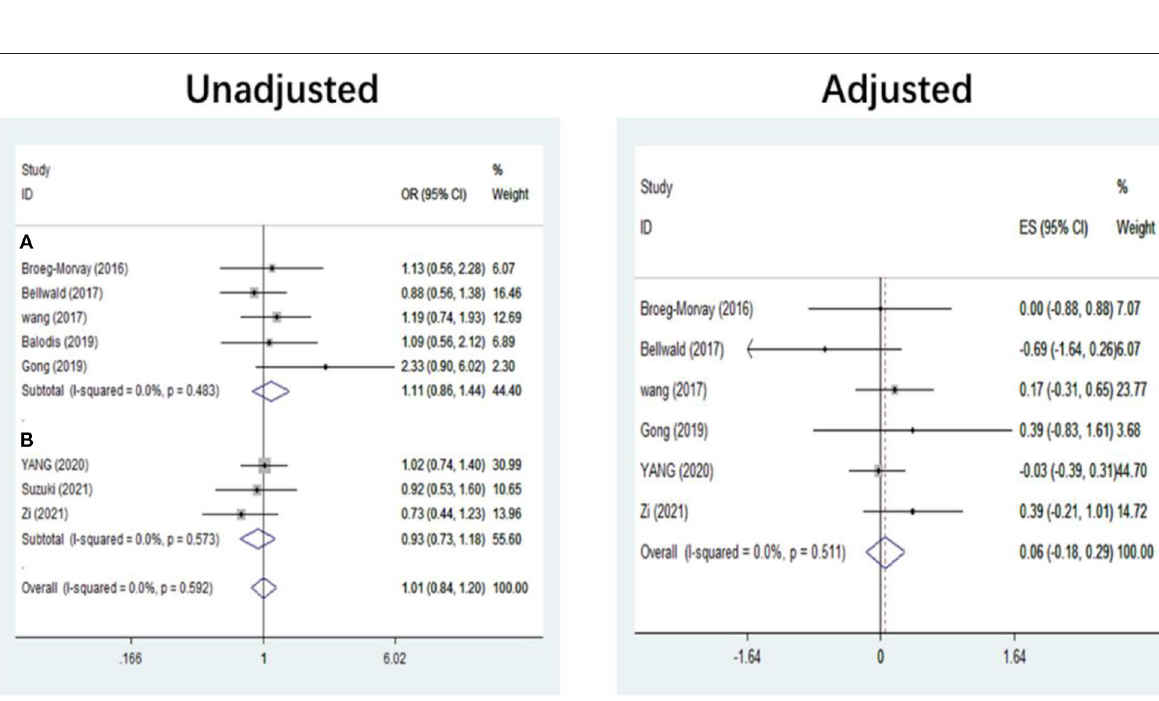
Frontiers in Neurology |